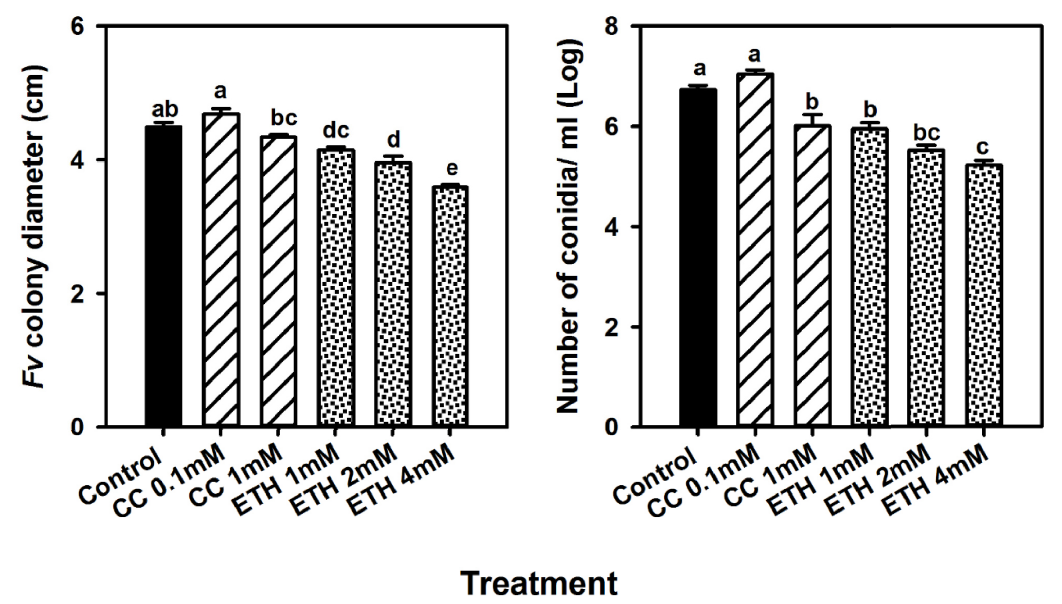
Fig 3. In-vitro effect of ethephon and cobalt chloride on mycelial growth of Fusarium virguliforme . Mycelia plugs were grown for fourteen days on PDA plates containing water, ethephon concentrations of 1mM, 2mM, and 4mM, or cobalt chloride concentrations of 0.1mM, and 1mM. Colony diameter (A), and number of conidia per ml (B) were measured fourteen days after incubation at room temperature under dark conditions. Each bar represents the mean of 18 replicates (6 plates × 3 runs) and the error bar represents the standard error of the mean. Means with different letters are significantly different ( P <